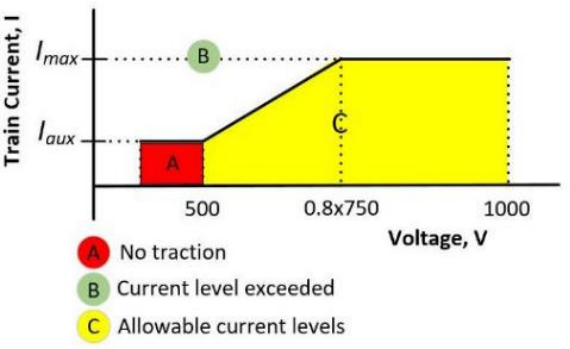
Figure A2. Permissible operating ranges of vehicle current against catenary line voltage.